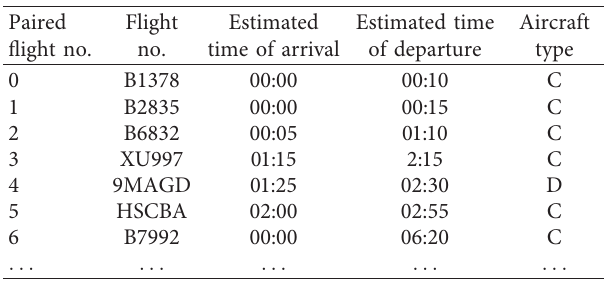
Table 2: Flight pair information sorted by estimated departure time. Paired Flight flight no.